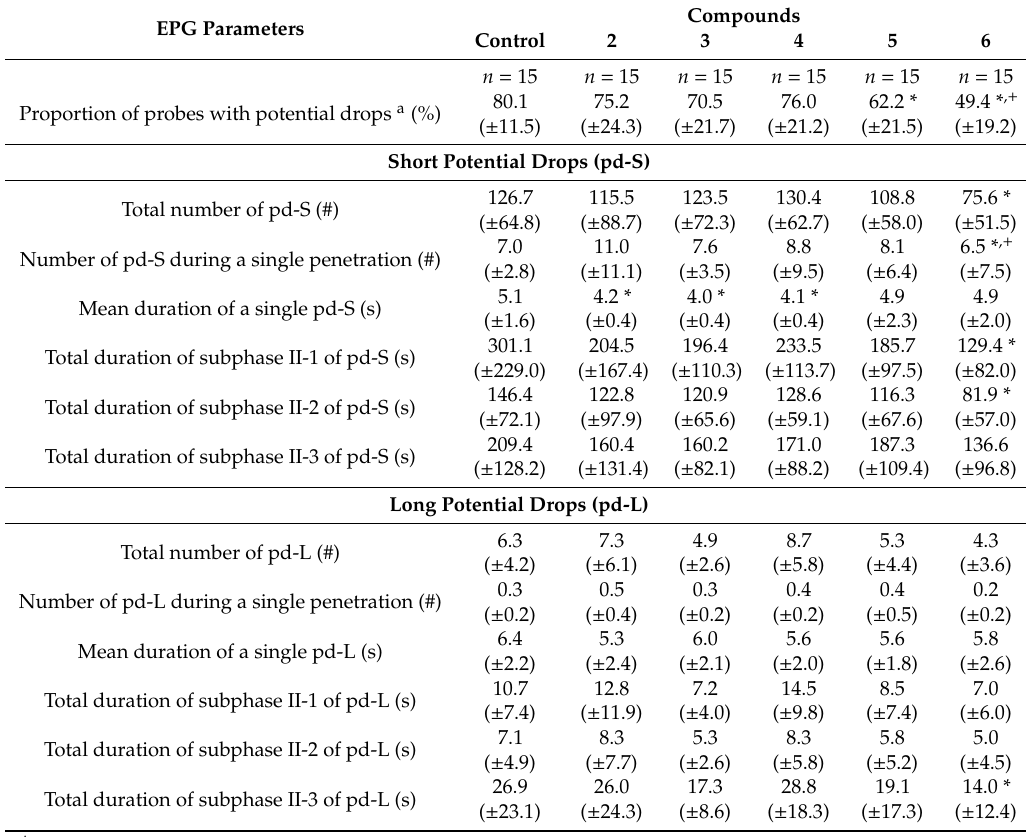
Table 3. Exploratory cell punctures in non-phloem tissues after application of ( + )- β -thujone ( 2 ) and its derivatives: bisulfite adduct ( 3 ), lactone ( 4 ), oxime ( 5 ), lactam ( 6 ) A . The same plant was used to maintain the aphid stock